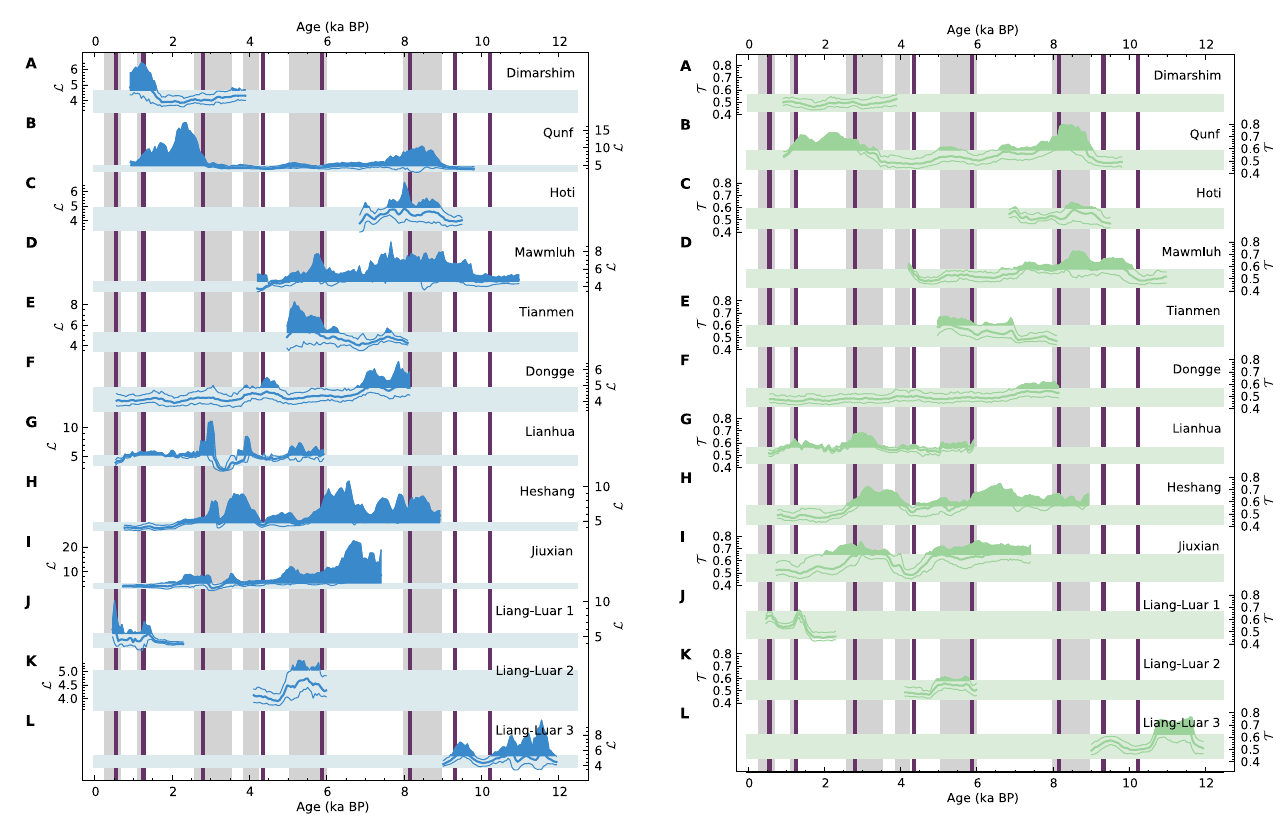
Figure A2. Time evolution of an indicator of rapid dynamical change (RN average path length L ) in monsoonal strength fluctu- ations obtained from a sliding window analysis of the residual oxy- gen isotope records displayed in Fig. A1. Median (thick dark blue lines) and 90% confidence intervals (thin dark blue lines) from an ensemble of 100 time series realisations of the COPRA algorithm for transferring dating uncertainties to uncertainties in proxy val- ues are shown. The predominant dynamical regime is marked by 90% confidence bounds from a stationarity test (horizontal light blue bands, Donges et al., 2011a, b). Deviations from this regime indicate epochs of significant climatic change (filled-in dark blue areas). Bond events (violet lines) and RCC episodes (grey bands) are displayed for reference.